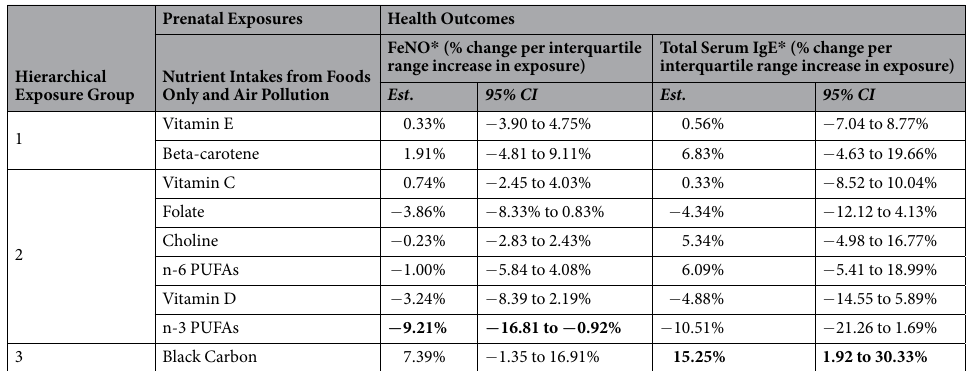
Table 3. BKMR Estimates for associations of Prenatal Nutrient Intakes (Foods Only) and Prenatal Air Pollutant (3 rd Trimester Black Carbon) Exposure with Allergic Disease Outcomes (FeNO and Total Serum IgE) in adolescence. * Model adjusted for maternal pre-pregnancy BMI, education, hay fever, and pregnancy smoking status (never, former, smoked during pregnancy); season of birth, sine and cosine of date at outcome measurement; and child’s race/ethnicity and sex. Estimates with p < 0.05 are in